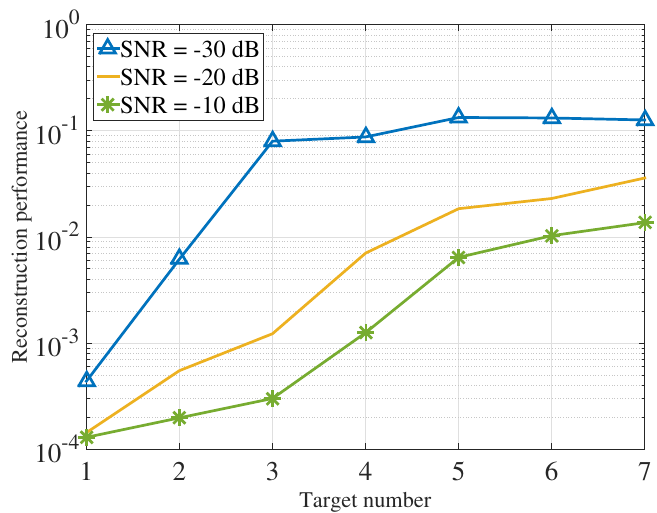
Figure 9. The reconstruction performance with different numbers of